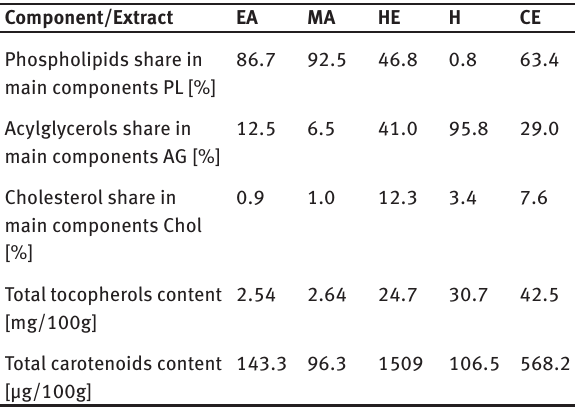
Table 1: Composition of extracts used for the preparation of liposomes